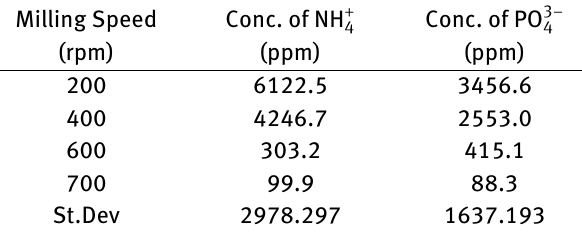
and PO 3− nutrients 4 4